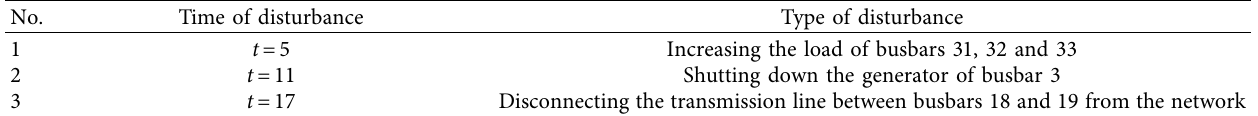
Table 5: Disturbances on the IEEE standard 57-bus network at diferent